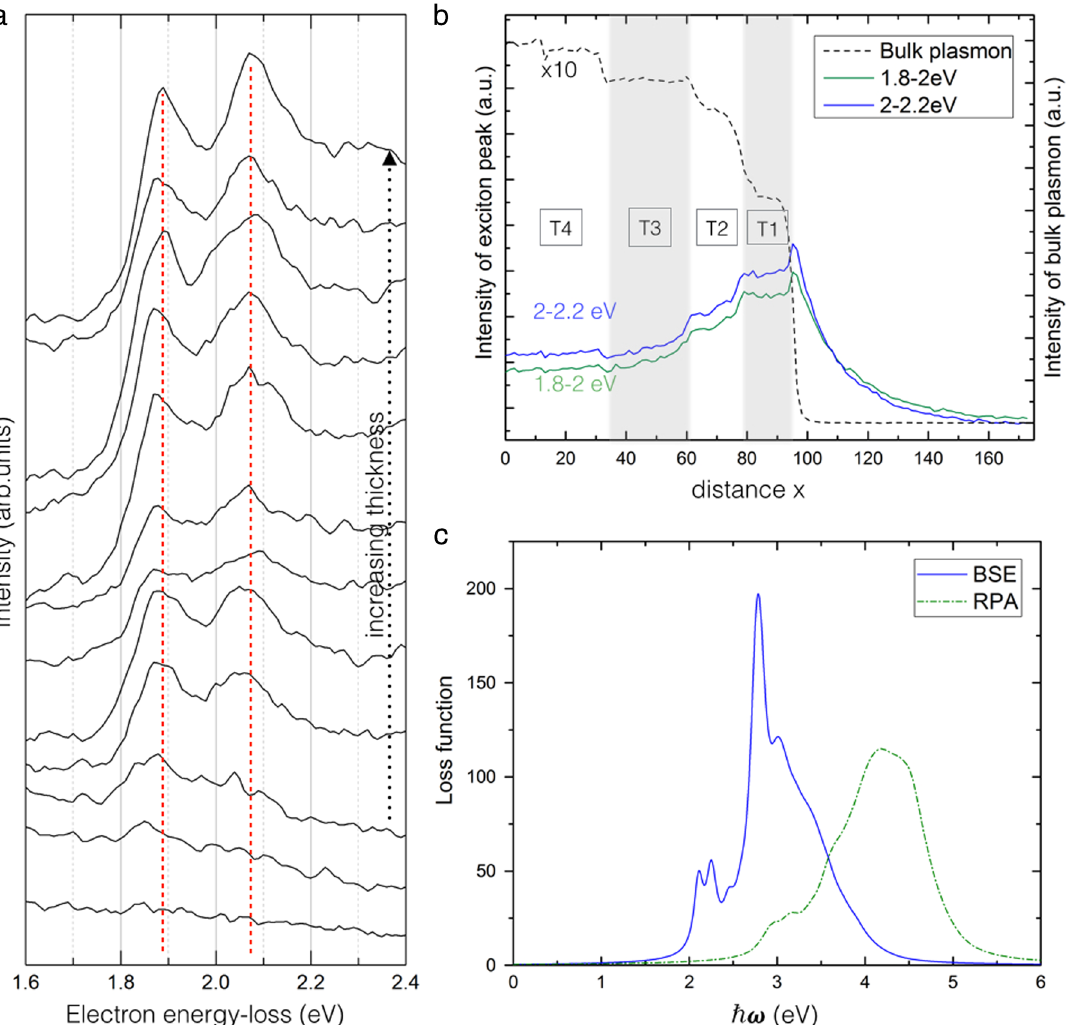
Fig. 3 Excitonic origin of ~ 2 eV peaks shown using Bethe-Salpeter equation (BSE) and monochromated LL-STEM-EELS. a Details from the monochromated LL-STEM-EELS (as found in Fig. 2d, peak i), showing the splitting of the peak — one peak is centred at ~ 1.88 eV and one at ~ 2.08 eV. No peak shift was observed of either peak when comparing edge regions with the inside of the fl akes. b Line pro fi les obtained showing the intensity variation from the inside of the fl ake to the vacuum of the LL-STEM-EELS for energy-loss integration windows 1.8 – 2 and 2 – 2.2 eV as well as 19.7 – 20.7 eV (bulk plasmon peak region) from the region as shown in Fig. 2b. For the bulk plasmon peak, the signal decays to 0 at position x = 100 nm, close to the edge of the fl ake. In contrast, the signals for 1.8 – 2 and 2 – 2.2 eV decay to 0 at x ~ 150 nm only. c Results from the BSE ( blue , solid line ) and RPA calculations ( green dashed line ) for a monolayer MoS 2. RPA represents a quasi-particle spectrum without the inclusion of electron-hole coupling. This gives excitonic peaks at ~ 2.1 eV — exhibiting A-B splitting of ~ 0.15 eV. This is in close agreement with the experiments where excitonic peaks were found at ~ 1.88 and ~ 2.08 eV. In addition, there is a resonance at ~ 3 eV. Overall, there is a large difference between the BSE and the RPA spectra, hence the excitonic effects which are at the origin of this difference are large. Only vanishingly small effects were found when including higher q contributions in the spectra, q = 0 dominates the spectra for